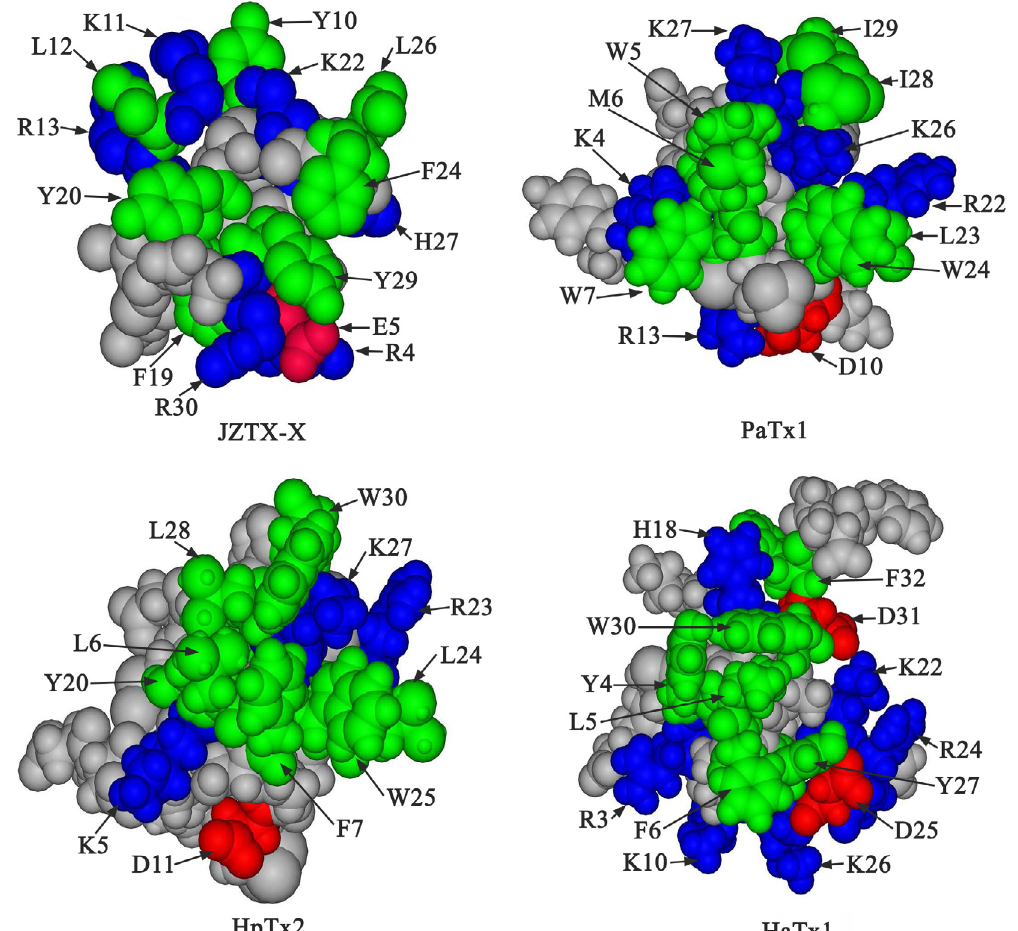
Figure 9. 3D structures of JZTX-X, PaTx1, HaTx1, and HpTx2: The JZTX-X models were acquired through homology modeling according to ω-GsTx SIA structure identified by NMR (PDB code: 1KOZ). The DS ViewerPro was utilized to produce CPK models. Those critical amino-acid residues predicted for PaTx1 to inhibit the potassium channels were marked with different colors. Candidate functional residues for the remaining three toxins were also denoted. Green, hydrophobic (Tyr, Ile, Met, Leu, Trp, Phe); Blue, basic (Lys, His, Arg); Red, acidic (Glu,